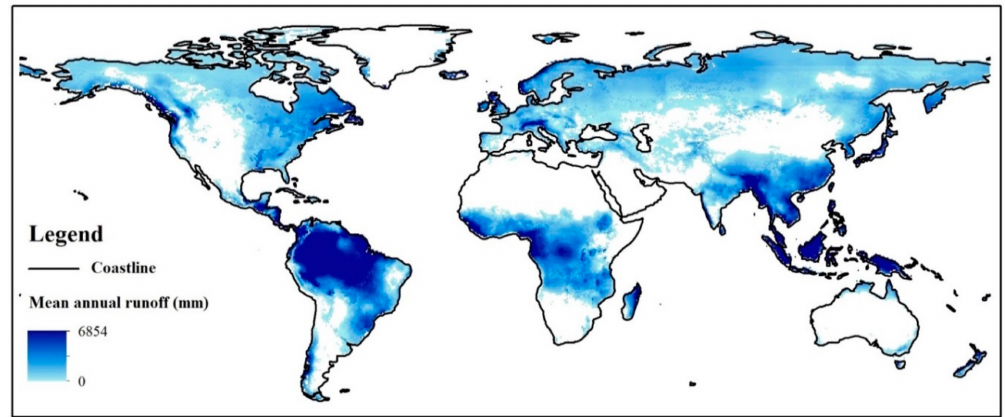
Figure 1. A global map of mean annual runoff during the period 1950–2000 with a spatial resolution of 0.5 degrees